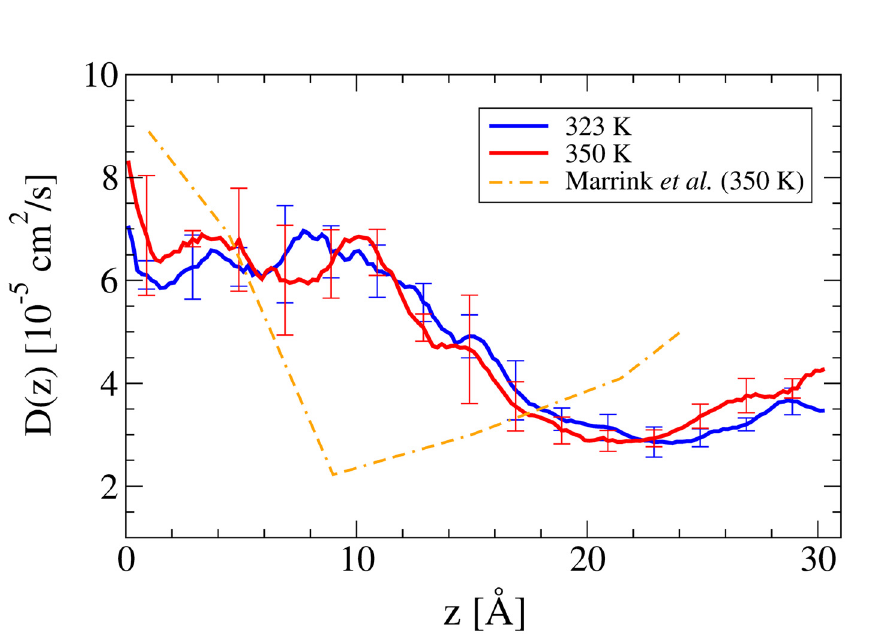
Fig 5. The position dependent diffusion coefficient, D(z), of O 2 across a DPPC bilayer at 323 K and 350 K with z = 0 being the bilayer centre and z = 30 Å being in the bulk solution. The error bars represent two standard